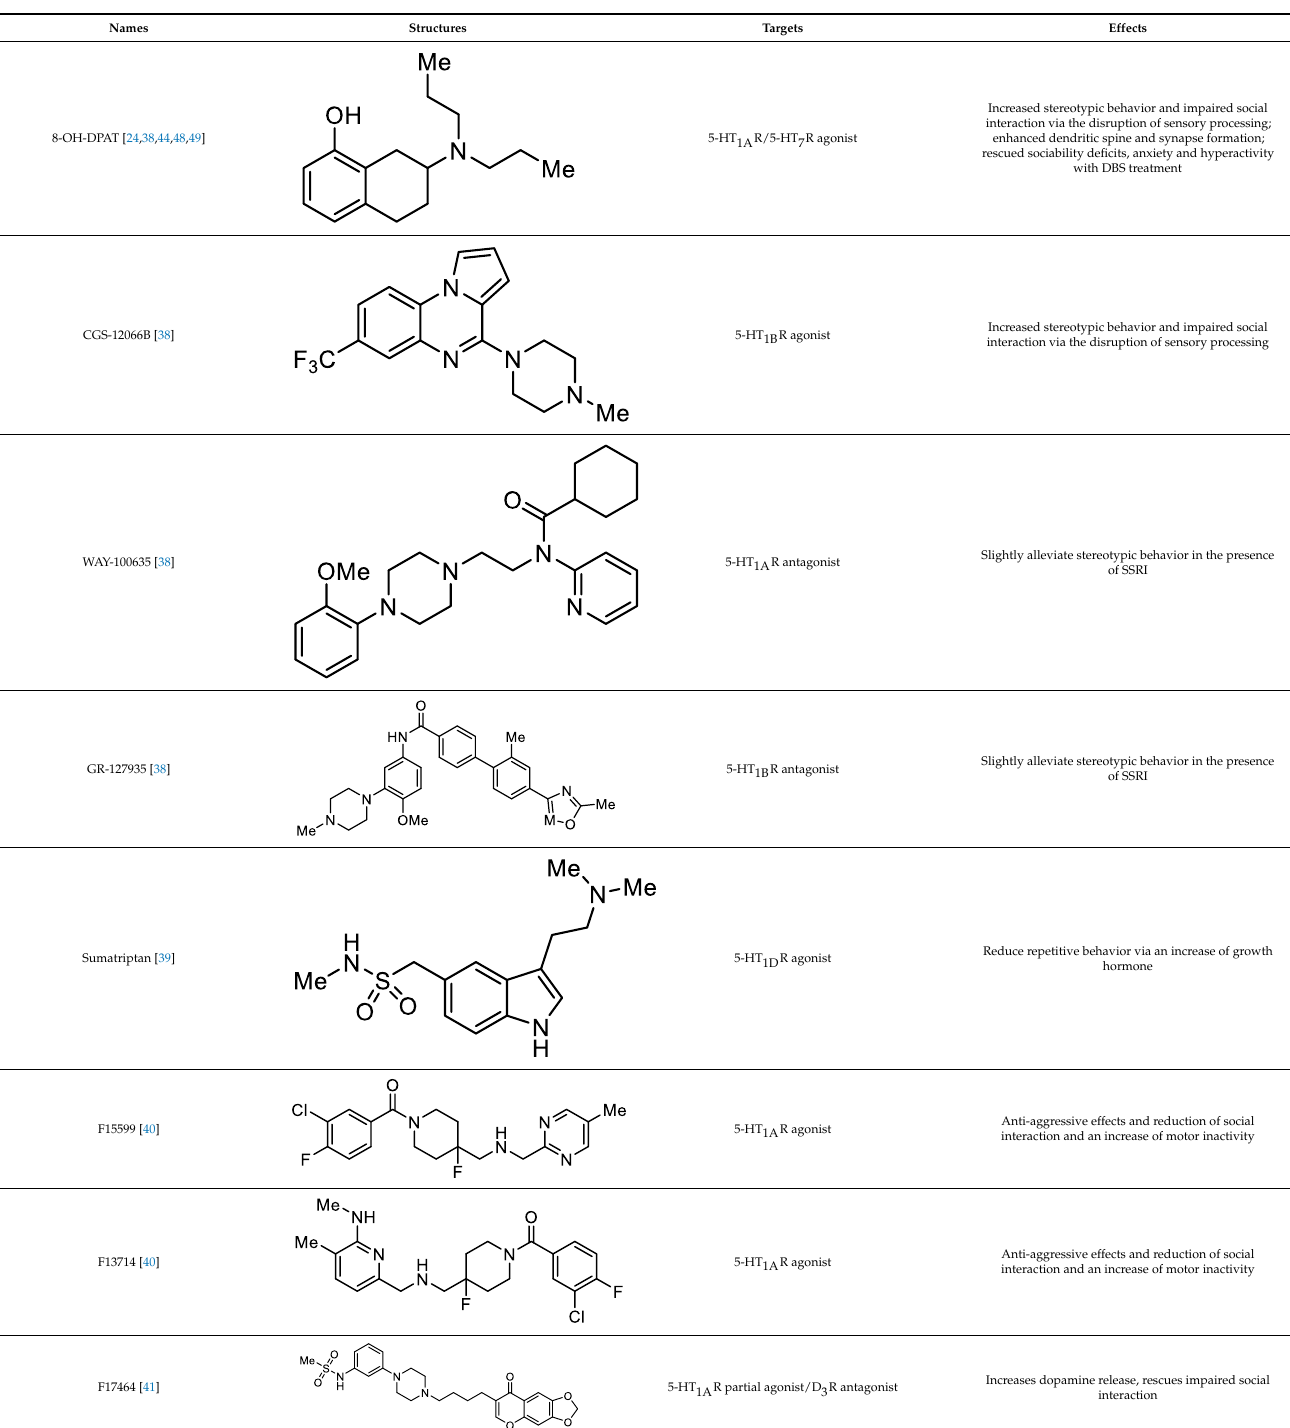
Table 1. 5-HT 1 R-targeted pharmacological agents which have potential effects on ASD